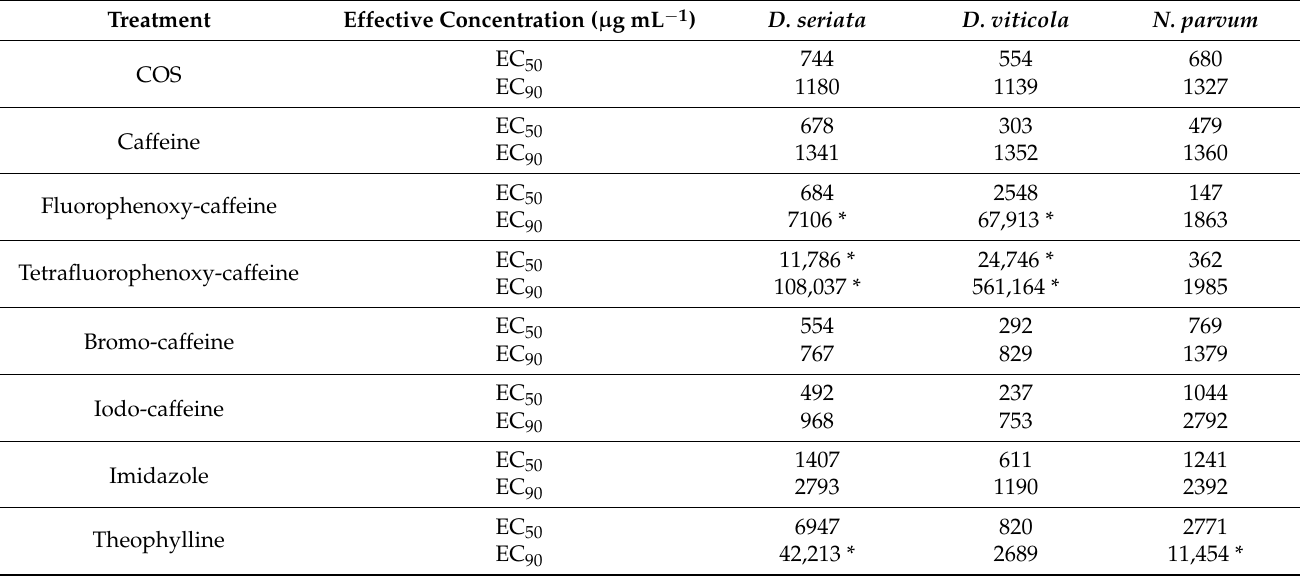
Table 5. Effective concentration values for chitosan oligomers (COS), caffeine, its derivatives, imida- zole, and theophylline against three fungi of the Botryosphaeriaceae family.